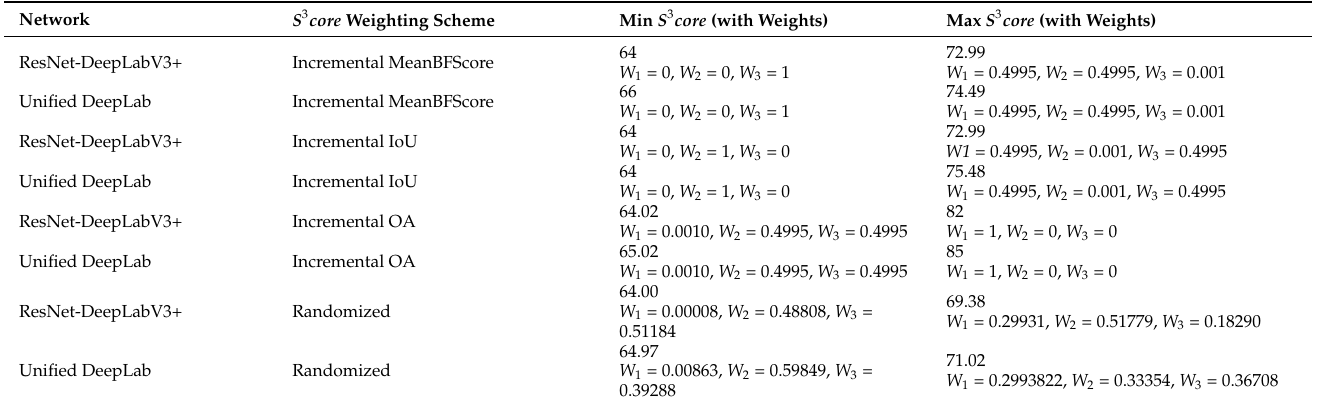
Table 9. Comparative Analysis with S 3 core (different weighting